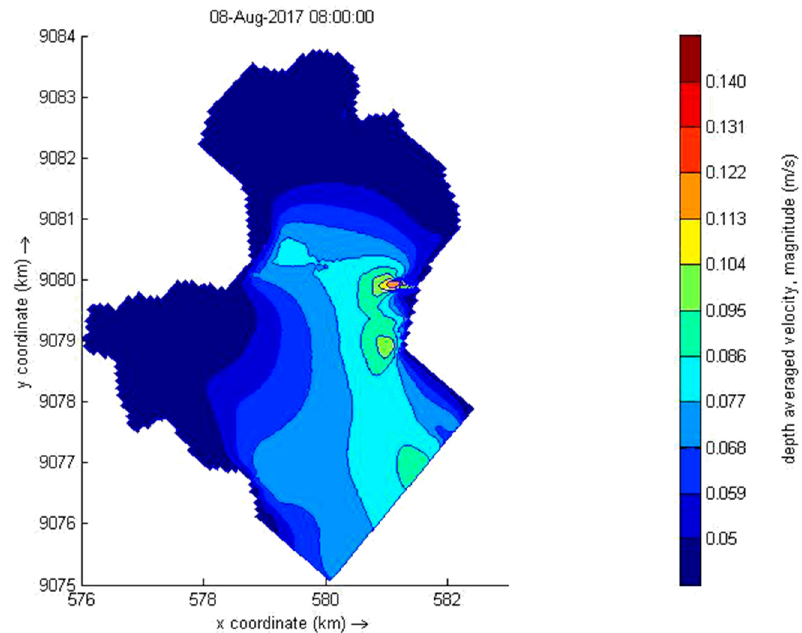
Figure 12. Current Modeling Overlay Results.